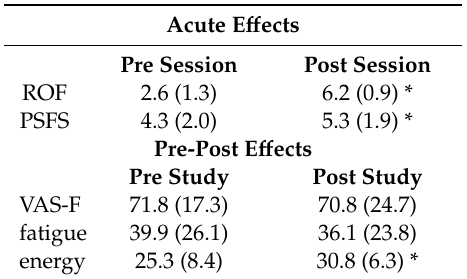
Table 2. Acute and pre-post effects of tDCS on fatigue and function. Averages for the Rating-of-Fatigue Scale (ROF; 10 point maximum) and Patient-Specific Functional Scale (PSFS; 10 point maximum) are shown from before and after each tDCS and exercise session. Visual analogue fatigue scale (VAS-F) values are shown from the start of the study to the end (5 – 6 weeks later). Values are mean (standard deviation). * p < 0.05 between pre and post.